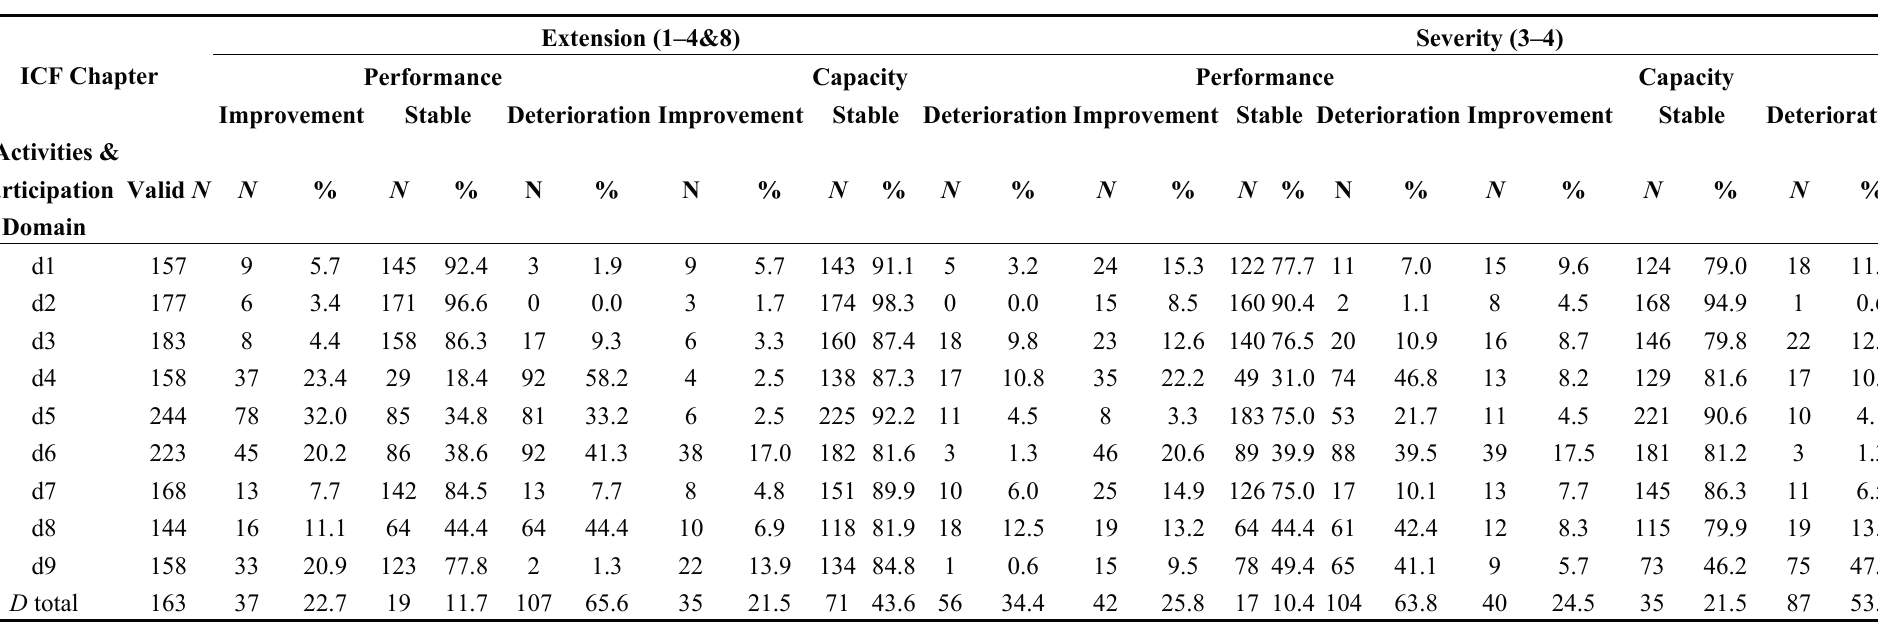
Table 4. Number and percentage of patients who improved, remained stable, or deteriorated with respect to the number of problems of any severity (extension index) or severe or complete problems (severity index) on the various chapters within the Activities & Participation